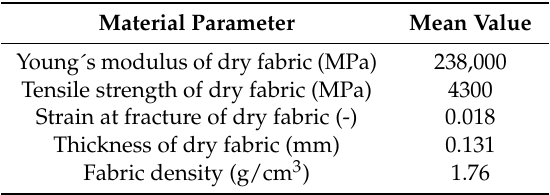
Table 1. Physical and mechanical parameters of the CFRP fabric.